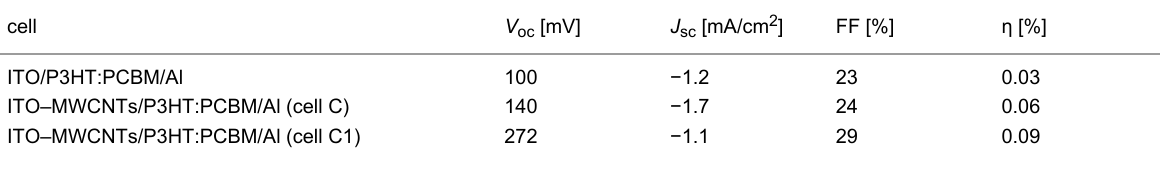
Table 2: Characteristics of the organic solar cells: open-circuit voltage ( V oc ), short-circuit current density ( J sc ), fill factor (FF) and power conversion efficiency ( η ). cell